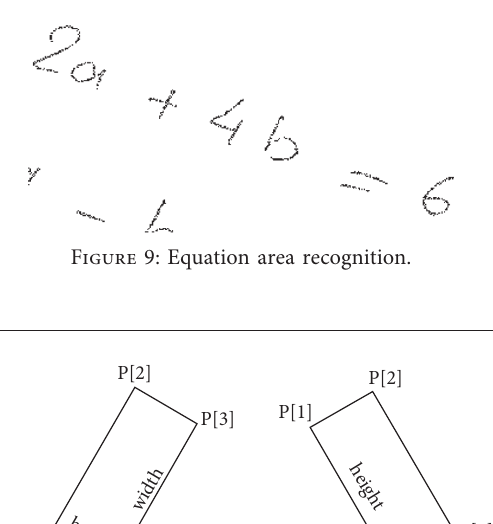
Figure 8: Equation area (a) before and (b) after processing.